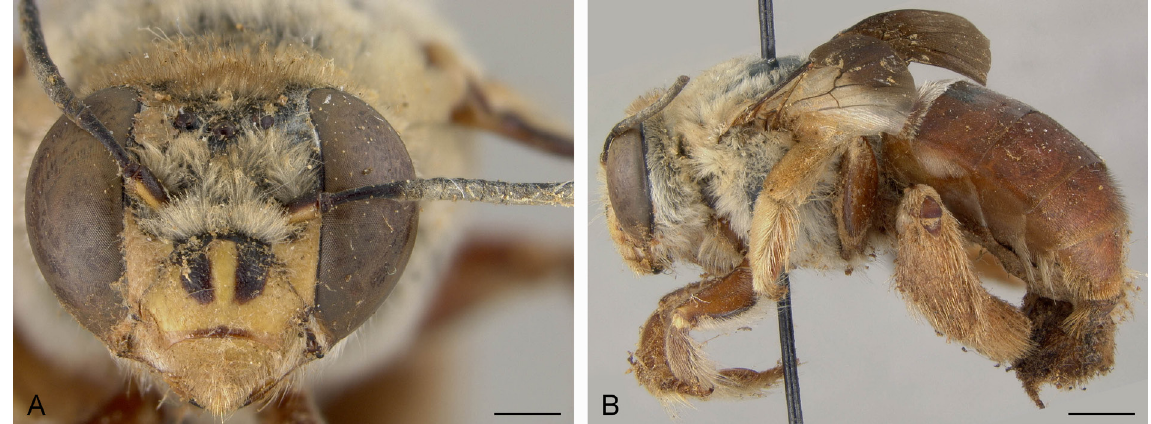
Fig. 26. Centris bimaculata carrikeri Cockerell, 1919, holotype, ♀ (NMNH; USNM ENT 00534188). A . Frontal view. B . Habitus, lateral view. Scale bars: A = 1 mm; B = 2